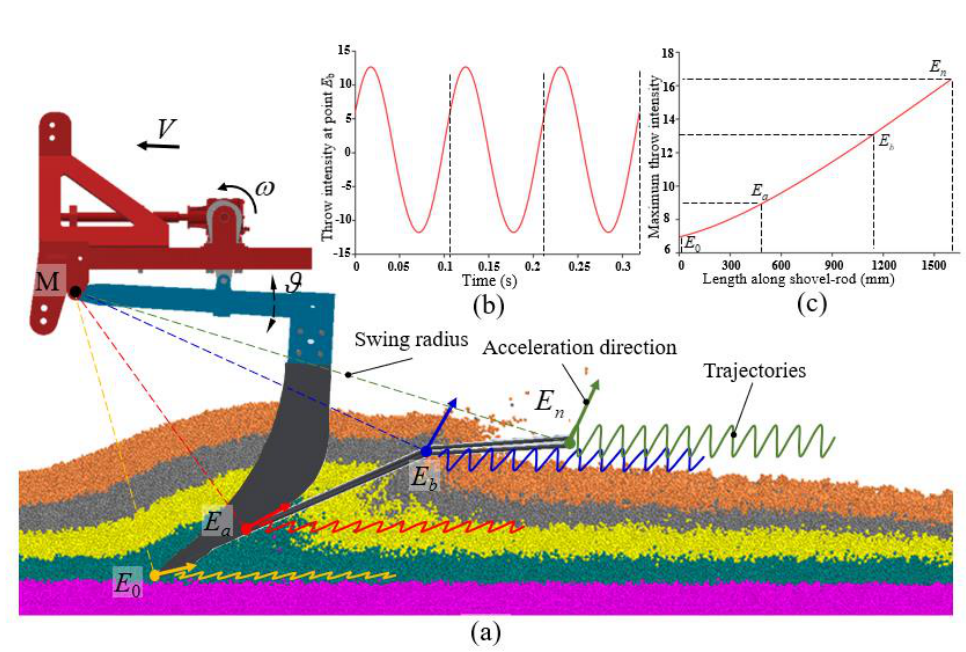
Figure 3. Working characteristics of the harvester ( a ) Harvesting process and variation in kinematic characteristics of shovel-rod, ( b ) E b point throw intensity-time variation pattern, ( c ) Variation of throw intensity with shovel-rod length.